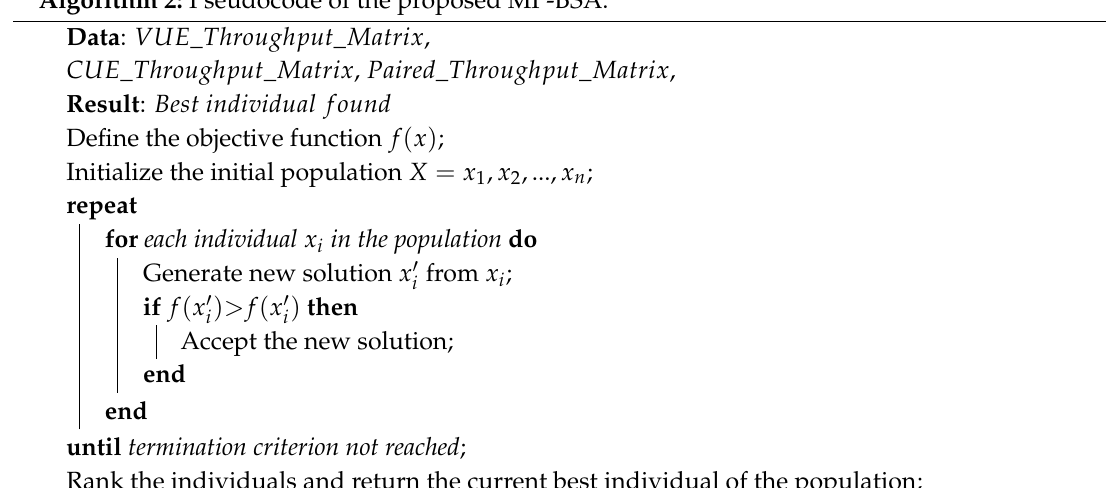
Algorithm 2: Pseudocode of the proposed MP-BSA.